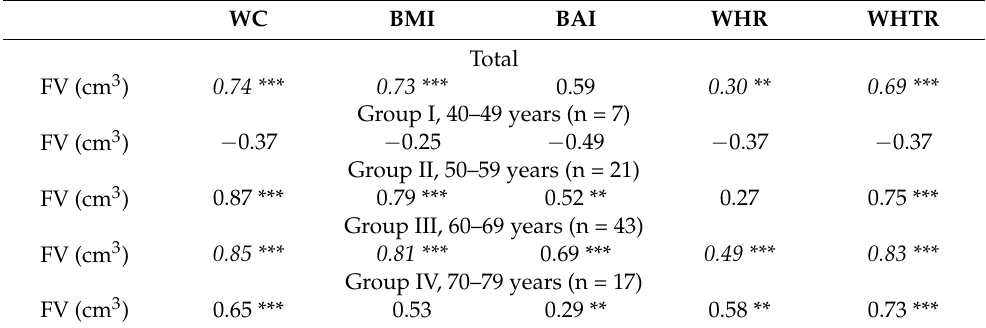
Table 3. Correlation of visceral fat volume with obesity indices.